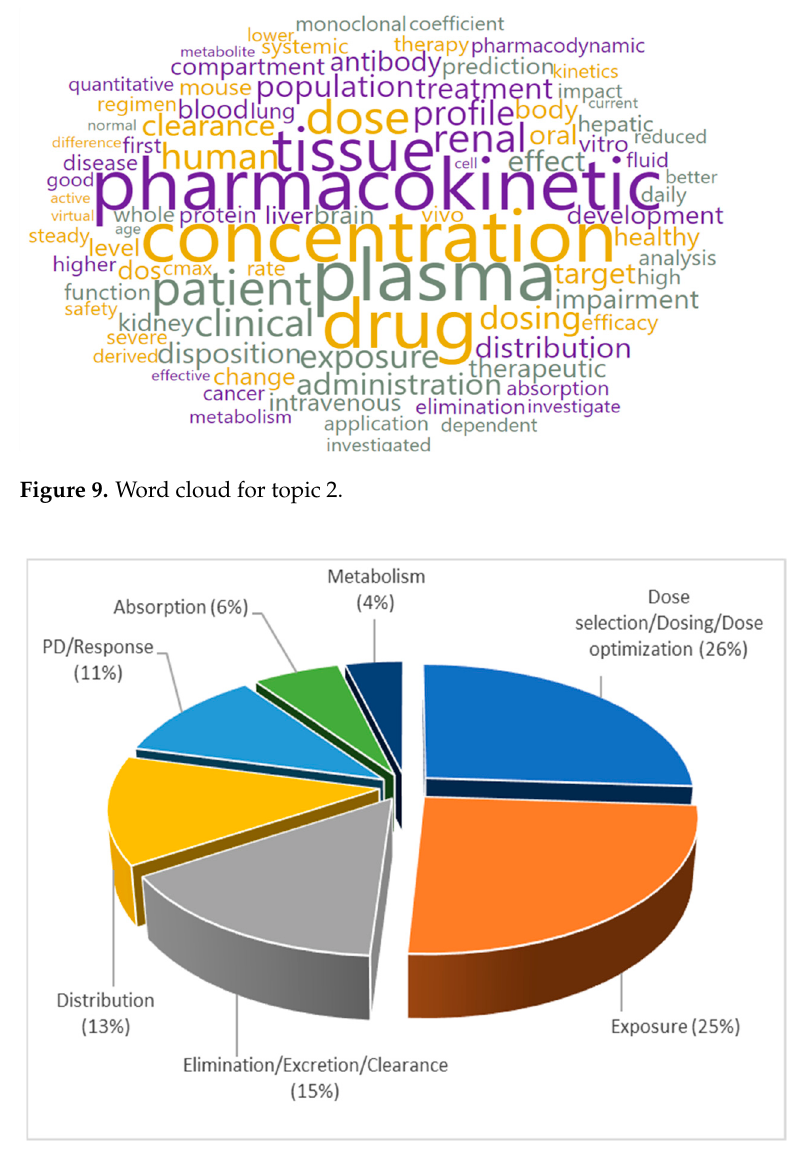
Figure 10. Distribution of published PBPK modeling per application area within topic 2, expressed as frequency (%), normalized to 100%.